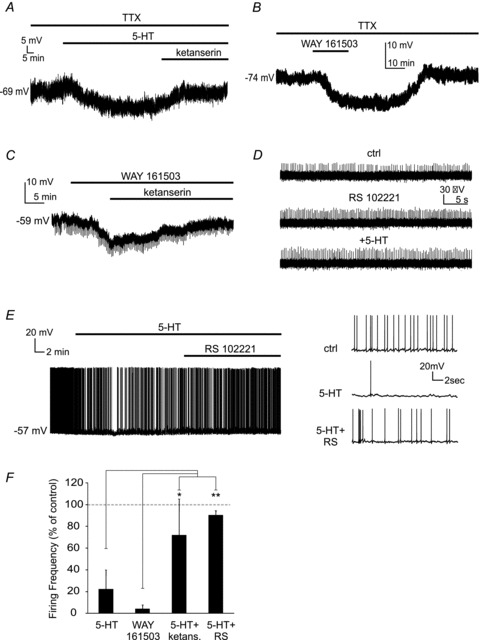
The effects of serotonin on LTSIs are mediated by 5-HT2C receptorsA, in a representative experiment, serotonin (30 μm) hyperpolarised an LTSI (recorded without any current injection) in the presence of TTX (1 μm). Subsequent addition of ketanserin (10 μm) caused the LTSI to depolarise to control level. B, another LTSI (recorded without current injection), with a resting membrane potential of –74 mV, was reversibly hyperpolarised by the 5-HT2C receptor agonist WAY 161503 (10 μm) in the presence of TTX. C, in a different LTSI, in the presence of TTX, the hyperpolarising effects of WAY 161503 (10 μm) were reversed by subsequent application of ketanserin (10 μm; still in the presence of WAY 161503). D, in a cell-attached experiment, the 5-HT2C receptor antagonist RS 102221 (1 μm) increased spontaneous firing frequency in a LTSI; in the presence of RS 102221, serotonin failed to affect the LTSI firing activity. E, in this experiment, an LTSI (recorded without current injection) displayed spontaneous firing activity in control solution. Serotonin induced a hyperpolarisation accompanied by a reduction in spontaneous firing frequency. Subsequent application of the 5-HT2C receptor antagonist RS 102221 (1 μm) repolarised the LTSI and increased spontaneous firing activity. F, bar chart showing the average changes in firing frequency (with respect to control solution) caused by combinations of serotonin receptor ligands. Only LTSIs that were spontaneously active in control solution were included in this analysis. Asterisks denote statistical significance (*P < 0.05; **P < 0.001, assessed with Mann–Whitney U test; n = 14 for serotonin; n = 6 for WAY 161503; n = 5 for 5-HT + ketanserin; n = 5 for 5-HT + RS 102221). Firing frequency in the presence of either serotonin or WAY 161503 was significantly (P < 0.001) lower than in control.